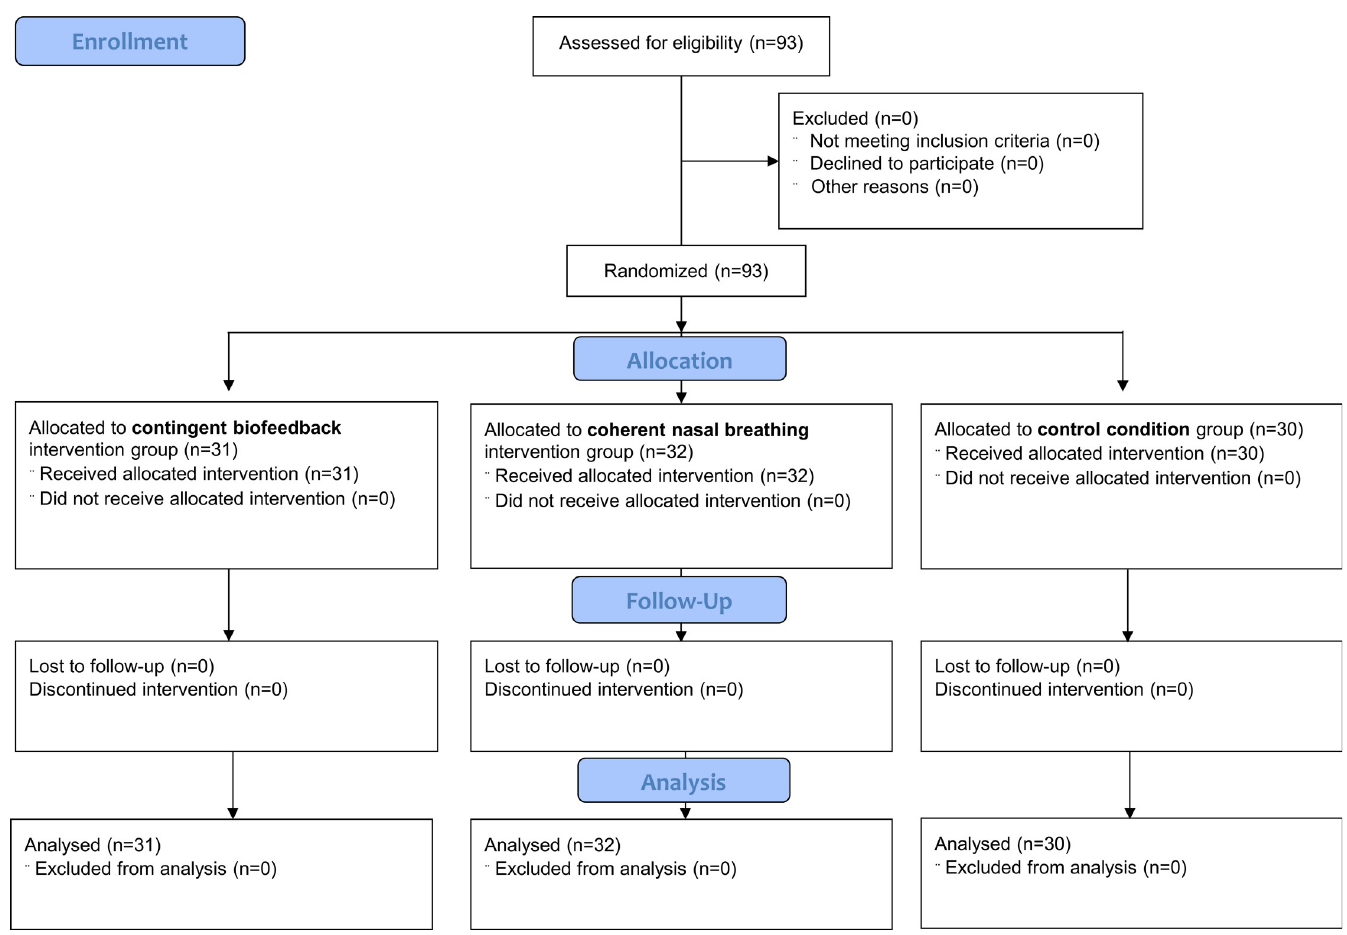
Fig 1. CONSORT flow chart illustrating the flow of participants through the study.